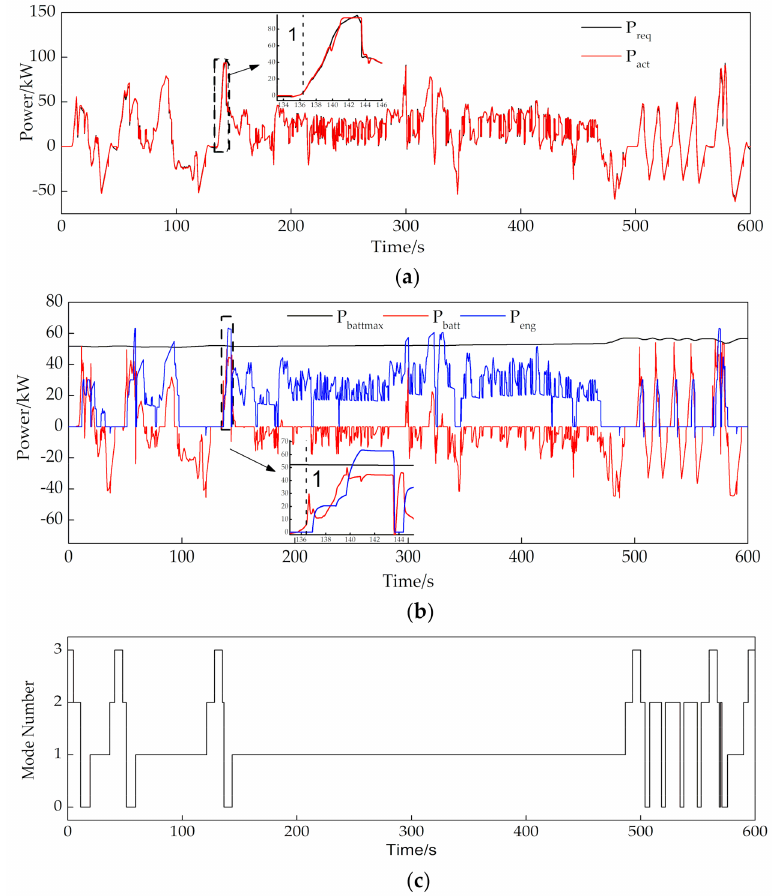
Figure 15. Results of AVPRB strategy under US06 cycle: ( a ) driving power; ( b ) battery power and engine power; ( c ) target operating